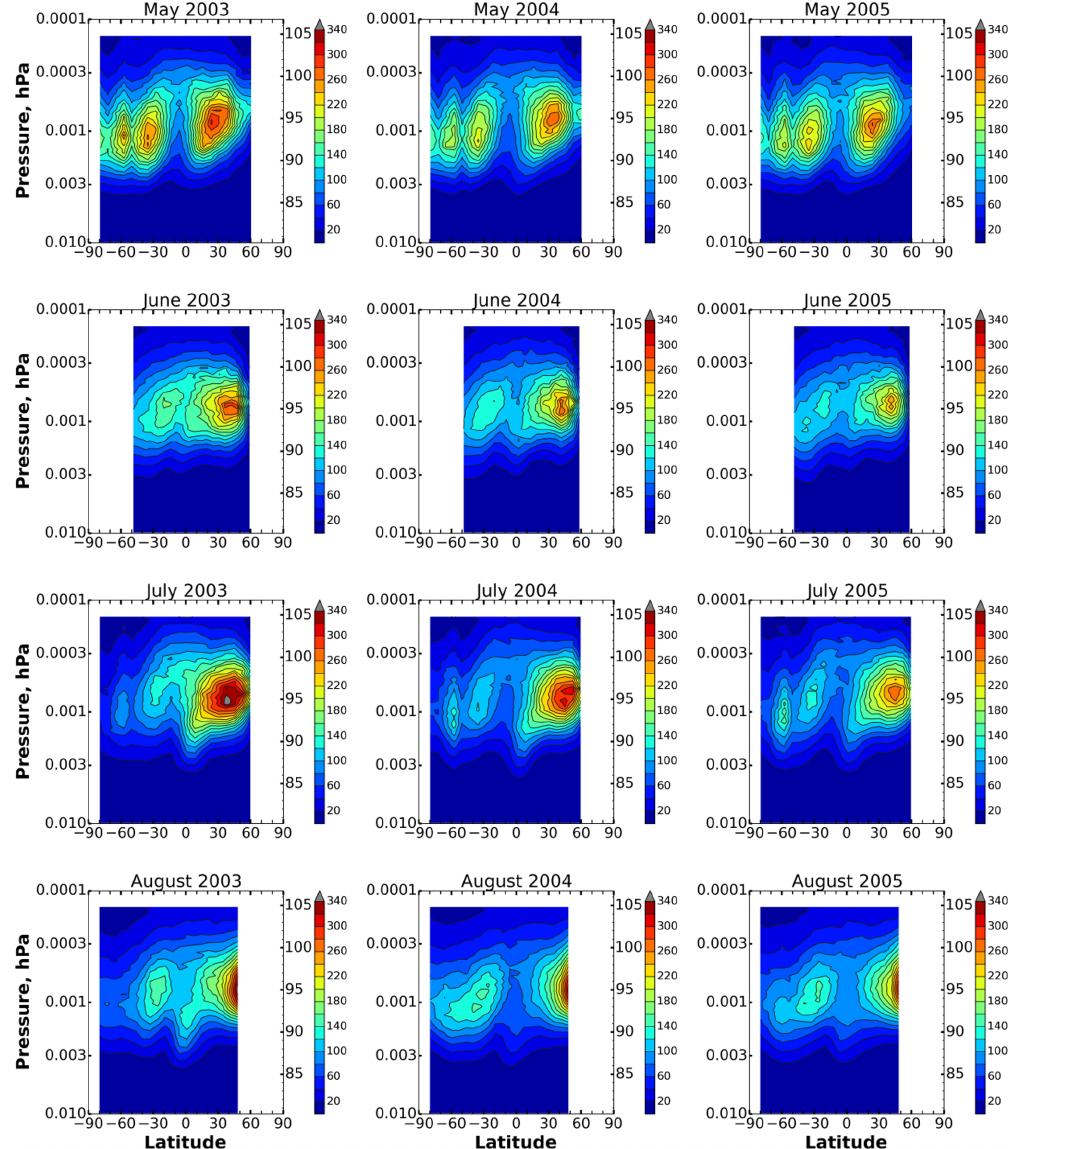
Figure 2. Monthly averaged O( 1 D) concentration (in cm − 3 ) in May–August of 2003–2005.